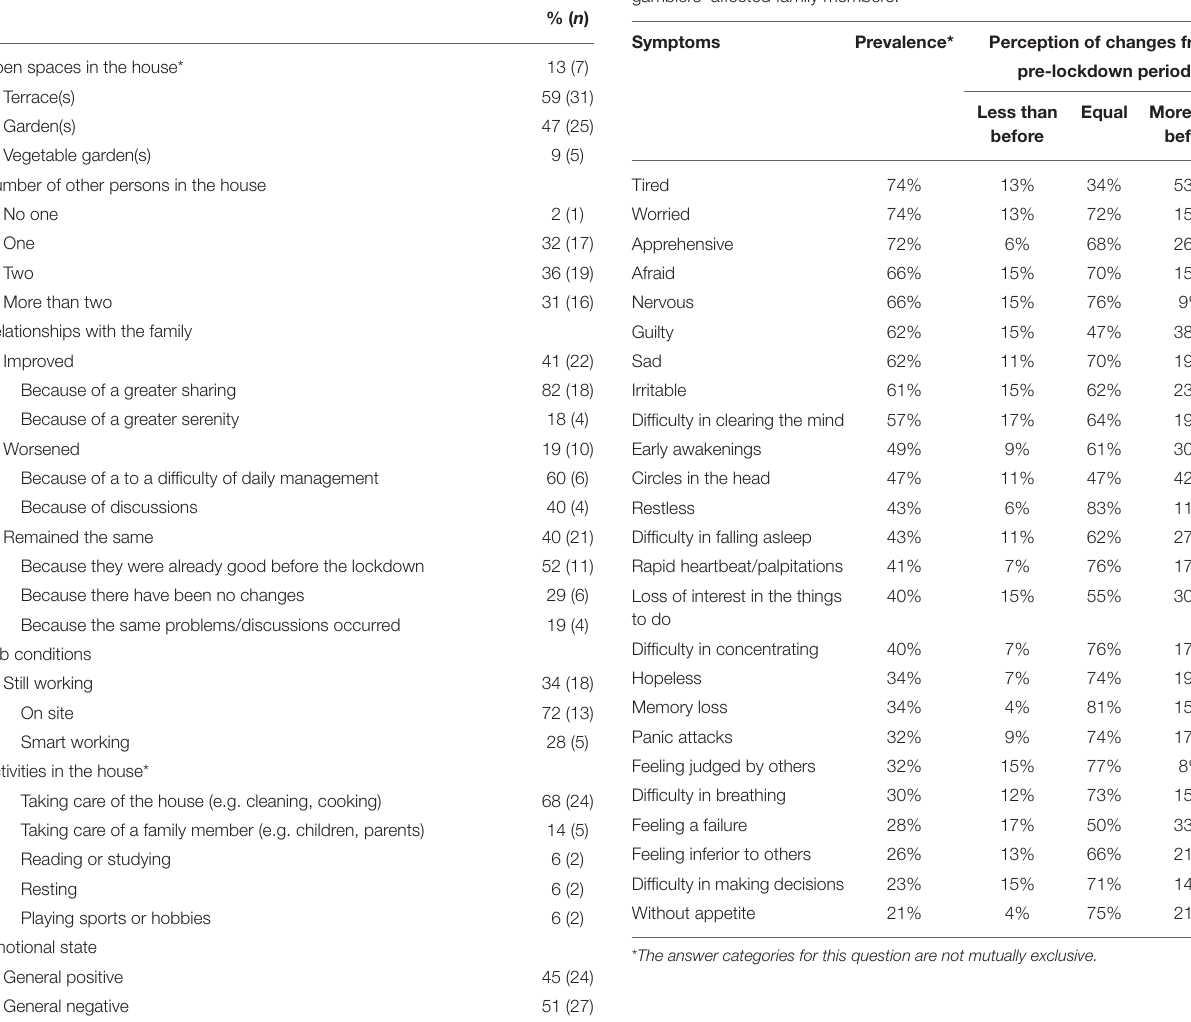
TABLE 3 | Affected family members’ life conditions and characteristics during lockdown.